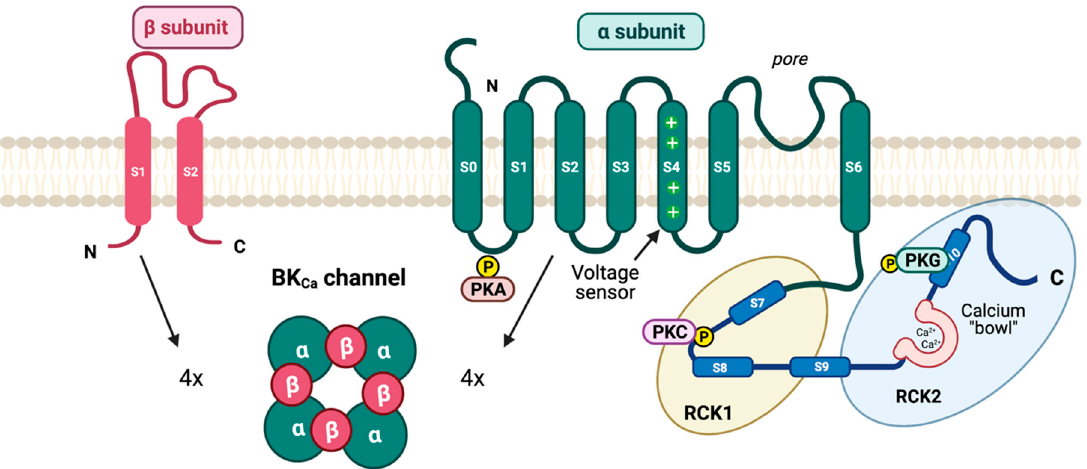
Figure 4. The structure of BK Ca channel. The BK Ca is a tetrameric channel complex assembled by four pore-forming α -subunits and four regulatory β -subunits. The α -subunit includes transmembrane domains (S0–S6) at the N -terminus and intracellular domains (S7–S10) at the C -terminus. The pore is formed between S5 and S6, whereas the S4 segment constitutes a voltage sensor. The phosphorylation site for PKA is found in the transmembrane domains, while the sites for PKC and PKG are located in the intracellular domains. In addition, the S7–S10 segments are associated with a regulatory potassium conductance domain (RCK1 and RCK2).